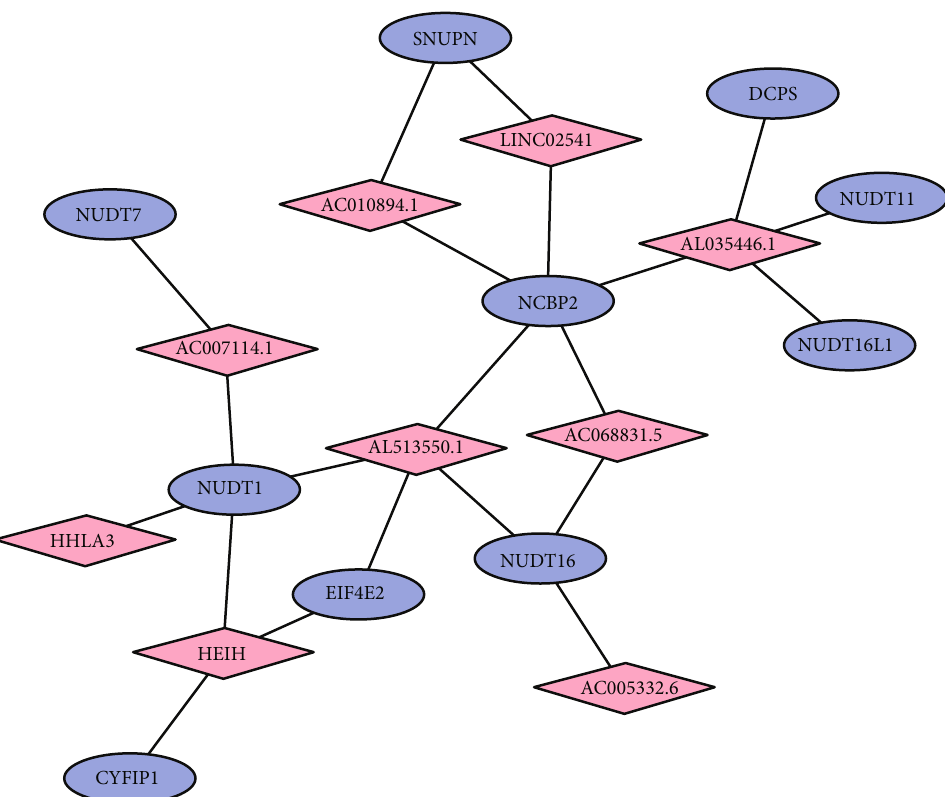
Figure 1: The coexpression network of m7G-related prognostic lncRNAs and mRNA. Pink diamonds represent lncRNAs, and blue ellipses represent mRNAs. Black solid lines represent the coexpression relationships between the mRNAs and